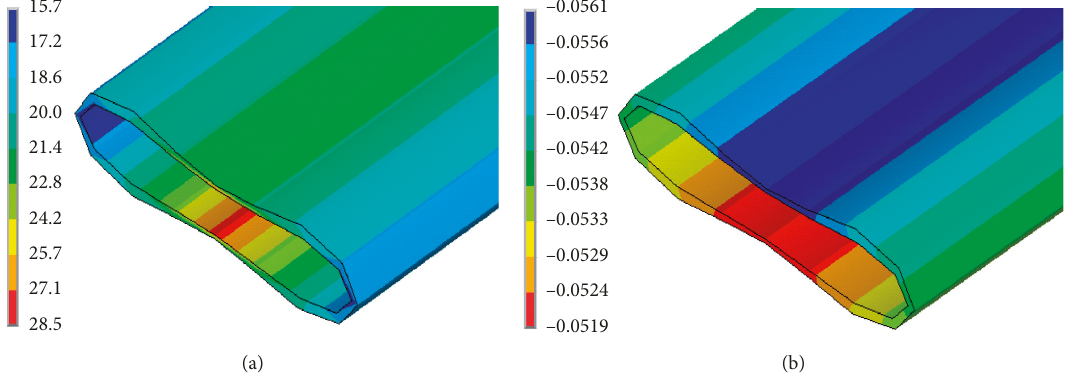
Figure 15: Thermal responses of the pipe under ambient temperature loads: (a) maximum principle stress distribution (MPa); (b) vertical displacement (mm). Table 4: Maximum principle stress extreme values of HSMP under ambient temperature loads (pipe spacing of 15 cm). Layers Depth (cm)